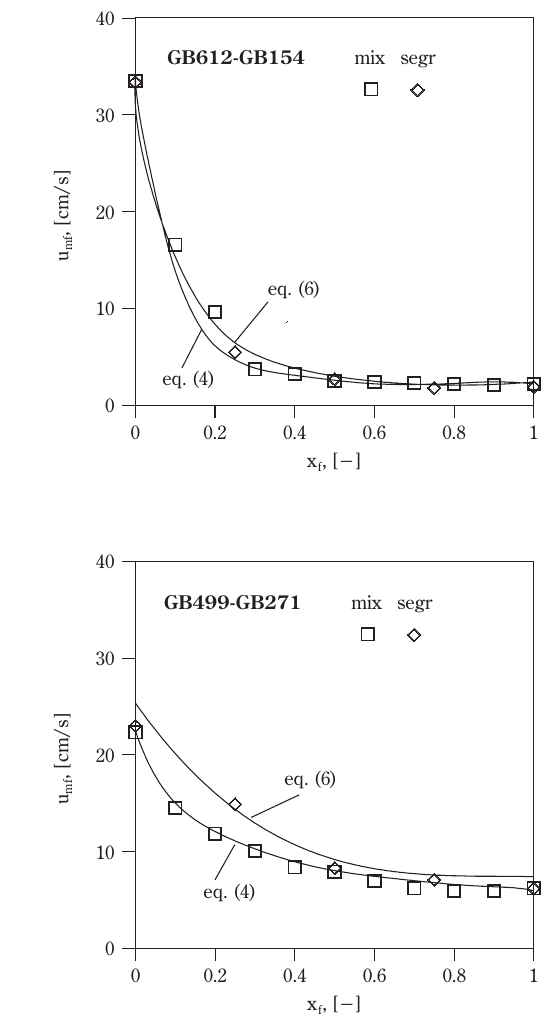
Fig. 3 Density segregating mixtures. Dependence of the mini- mum fluidization velocity on composition.